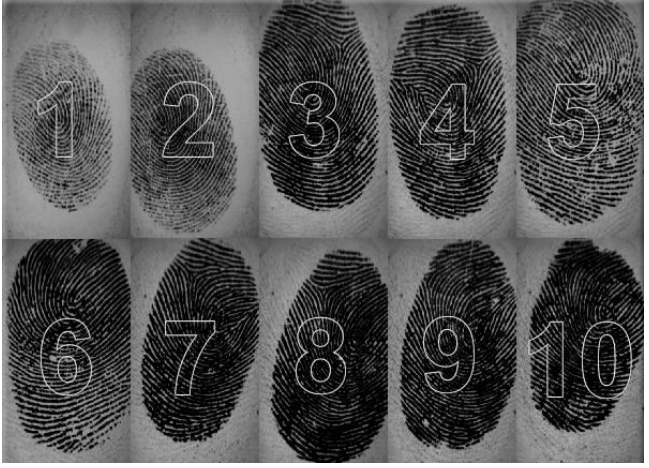
Figure 11. Ten fingerprint images of an individual from our database (from “1” to “10”, from the left to the right, respectively).